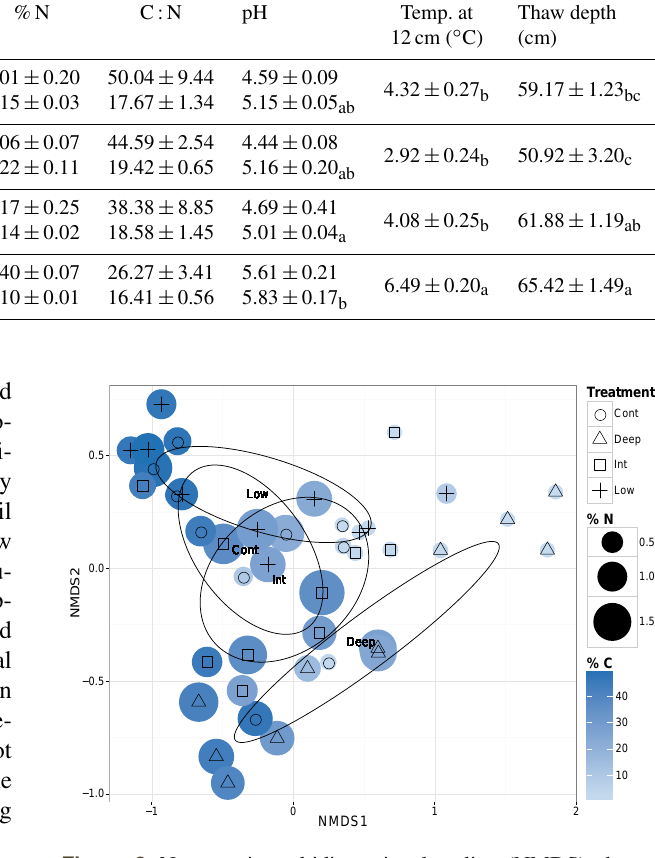
Figure 2. Non-metric multidimensional scaling (NMDS) plot us- ing Bray–Curtis dissimilarity matrices (stress = 0.090, Shepard plot non-metric R 2 = 0.992). Each point represents the bacterial com- munity structure within one of the 41 total samples used for DNA extraction from all soil depths (organic, transition, and mineral). Colours indicate %C ranging from 1.4% (light blue) to 48.6% (dark blue), bubble size indicates %N ranging from 0.09% (small) to 1.95% (large), and shapes indicate snow accumulation treatments (Control, Deep, Int., Low). Ellipse centroids represent treatment group means, while the shape is defined by the covariance within each